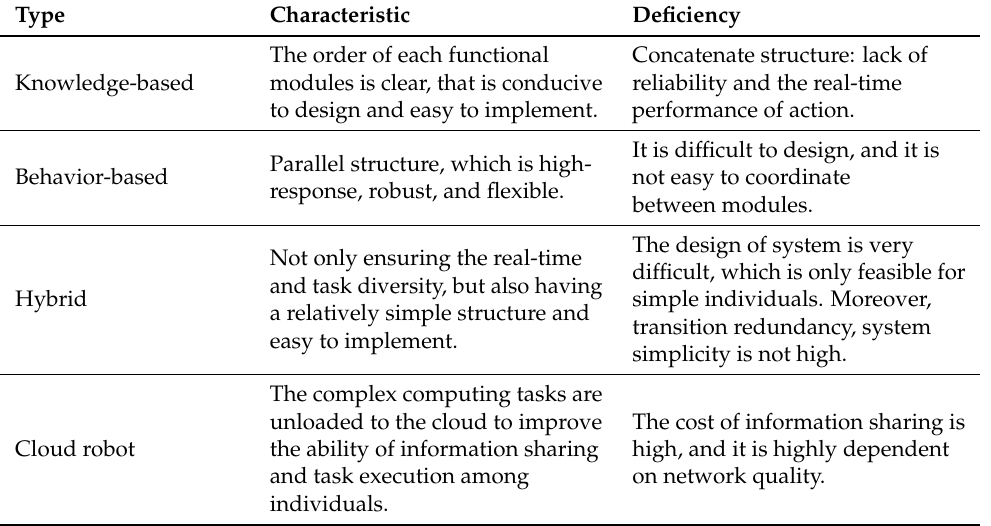
Table 3. Comparison of architecture characteristics of automation